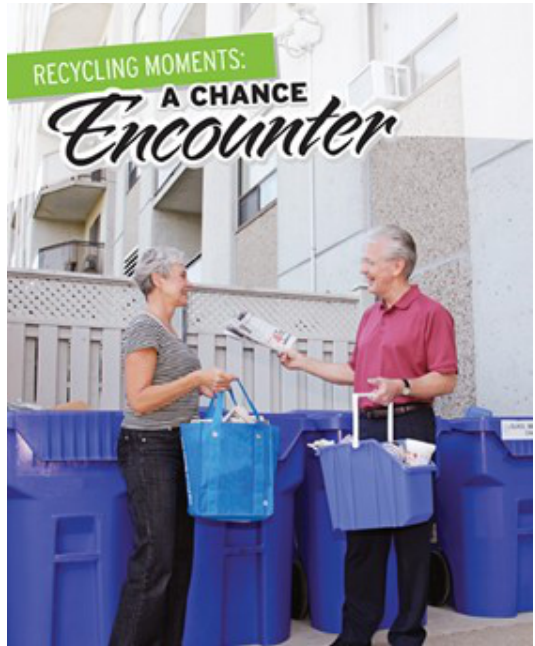
Figure 9. Sample Sign # 1.